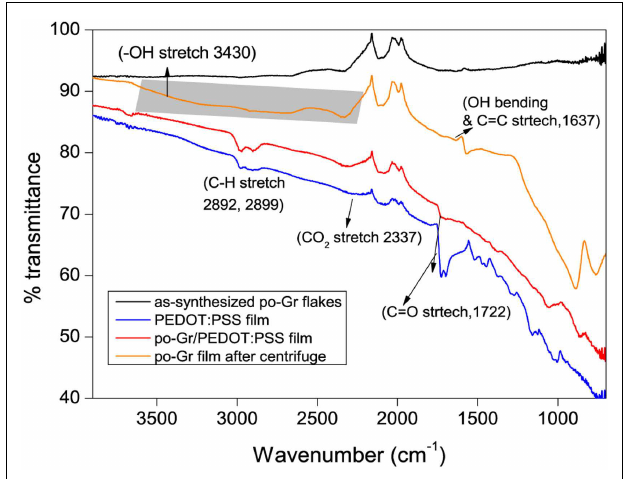
FIGURE 4 | FT-IR Spectra of po-Gr flakes, po-Gr film (prepared after centrifugation), po-Gr/PEDOT:PSS film, and PEDOT:PSS film (highlighted area in the figure shows the –OH stretch due to partial oxidation of po-Gr sheets) .